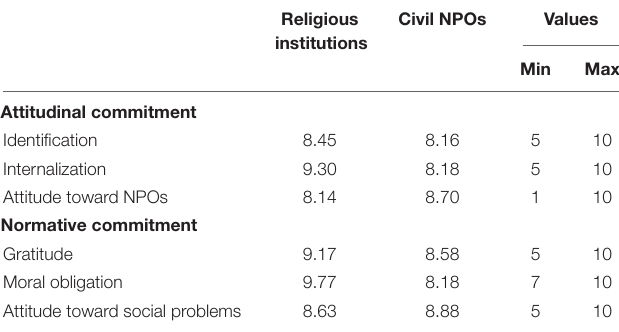
TABLE 5 | Descriptive statistics on volunteer helping